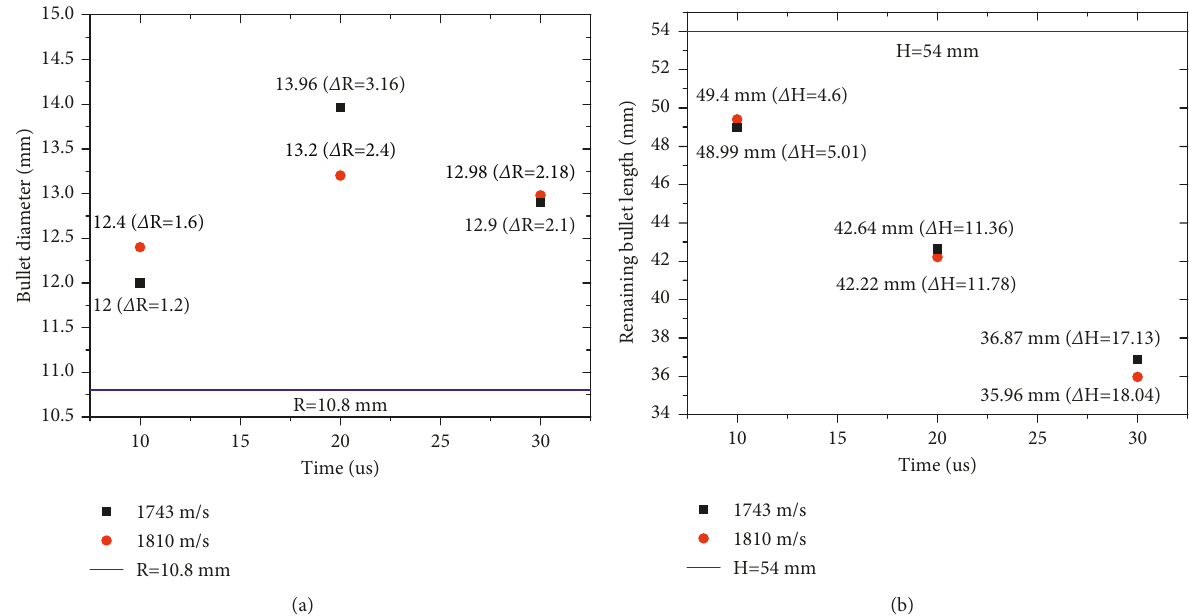
Figure 13: Change in the projectile diameter and projectile length over time. (a) Projectile diameter. (b) Projectile